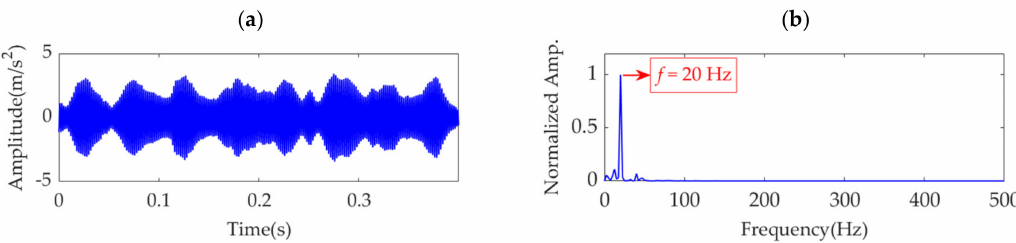
Figure 8. Desired mode obtained by VME with α = 32,500: ( a ) time–domain waveform and ( b ) SES.